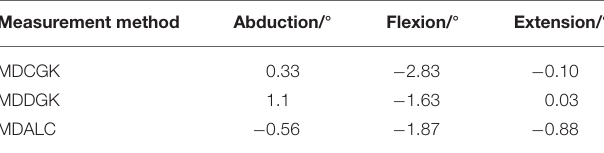
TABLE 1 | The mean differences through different detection methods. Measurement